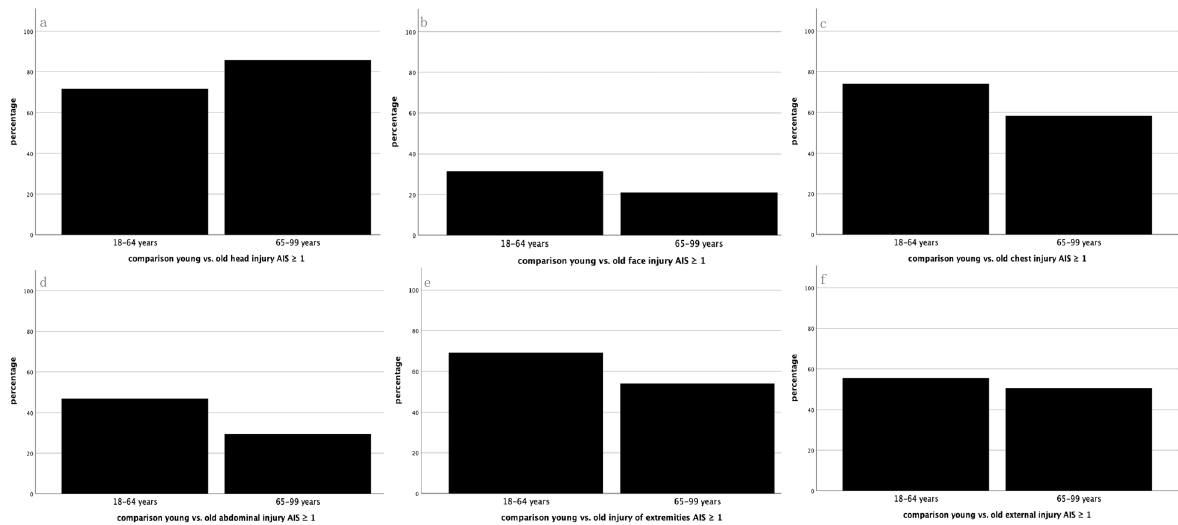
Figure 2. Percentage distribution of prevalent injuries by ISS body region: ( a ) head; ( b ) face; ( c ) chest; ( d ) abdomen/pelvis; ( e ) extremities; and ( f ) external/other. The black bar represents AIS ≥ 1 injuries.